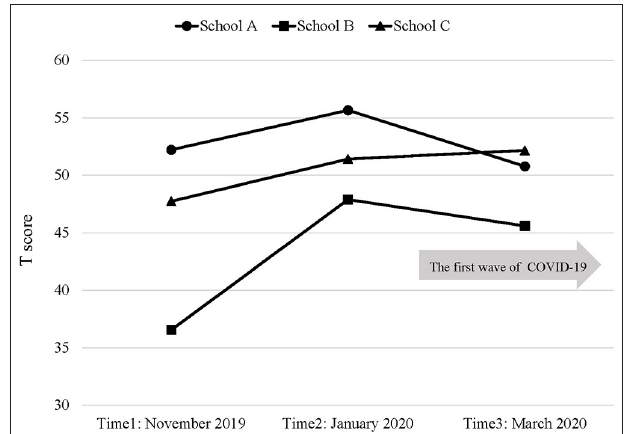
FIGURE 1 | T scores of the